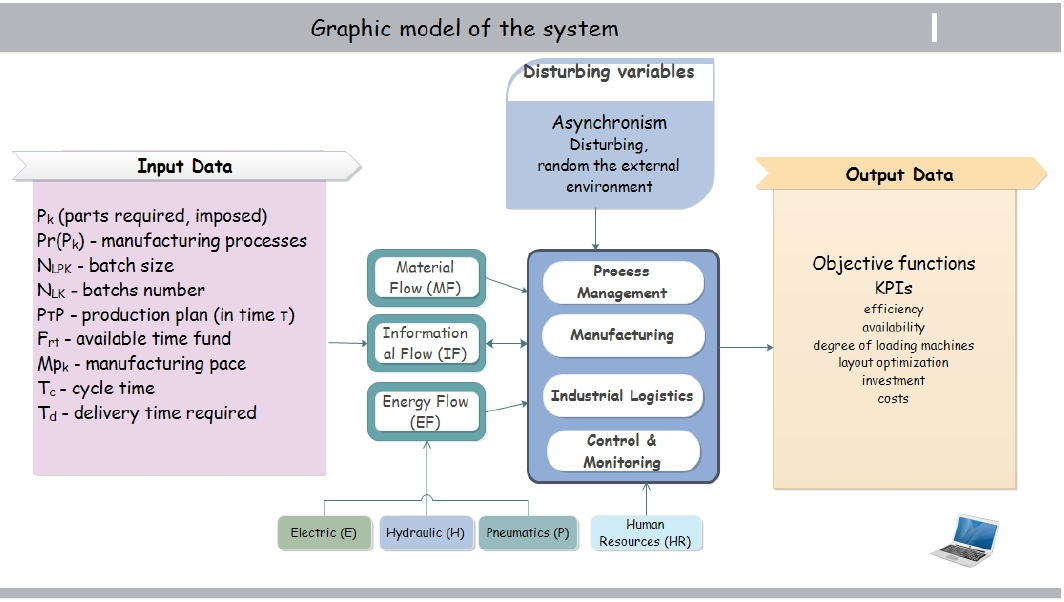
Figure 1. Graphic model of the system.